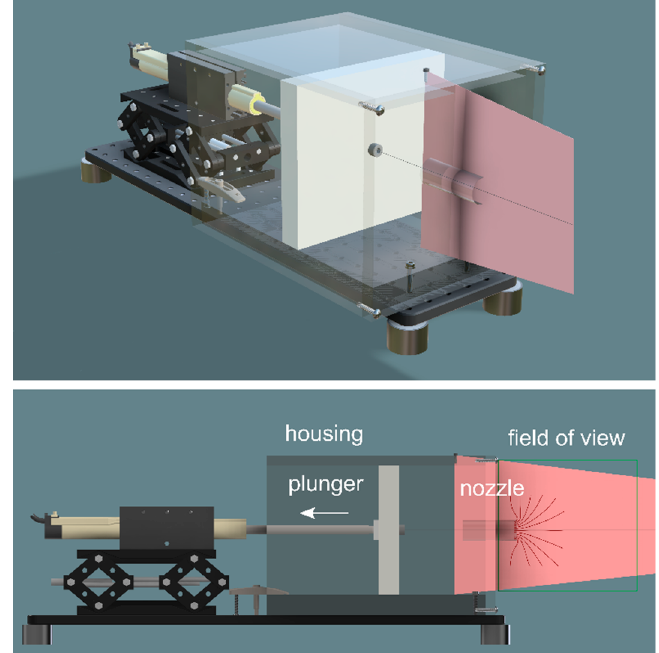
Figure 2. Sketch (perspective and elevation) of the mechanical suction-feeder model, showing the plunger (grey plate, area 191 mm × 191 mm) within its housing (transparent box) mounted onto a breadboard (black base); the actuator is mounted on a laboratory jack and withdraws the plunger to create a suction flow into the nozzle (cylinder mounted into the face plate of the housing); a laser sheet (red) illuminates the flow near the nozzle. The mechanical model is submerged in a 200 L tank containing mineral oil.